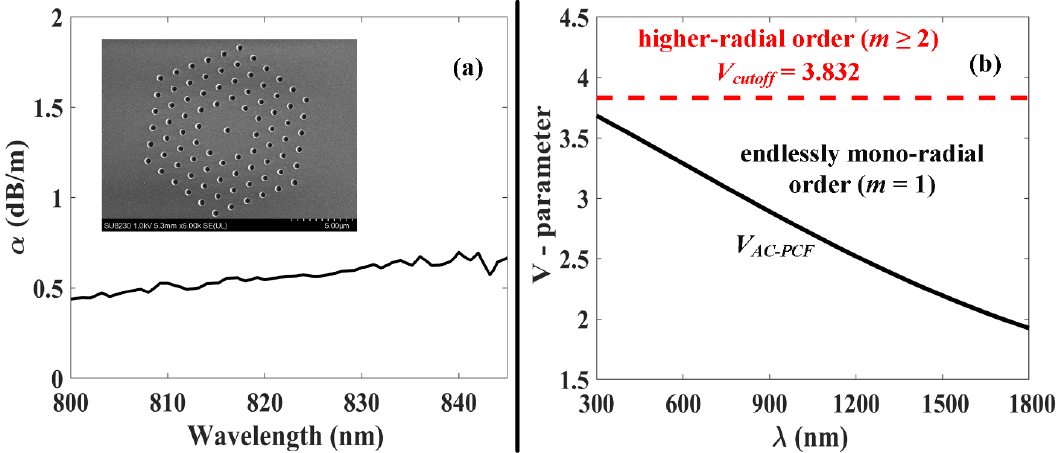
Figure 1. ( a ) Cutback losses of the used annular core photonic crystal fiber (AC-PCF), where the scanning electron microscope (SEM) image of the actual AC-PCF is shown in inset. ( b ) V-parameter of the AC-PCF as a function of the input wavelength in the 300–1800 nm range as calculated with finite-element method (FEM) simulations.